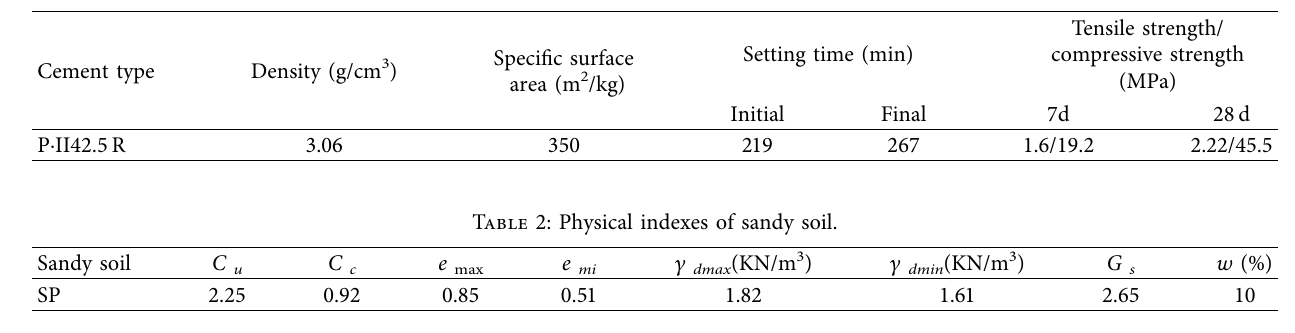
Table 1: Physical properties of P · II42.5R.